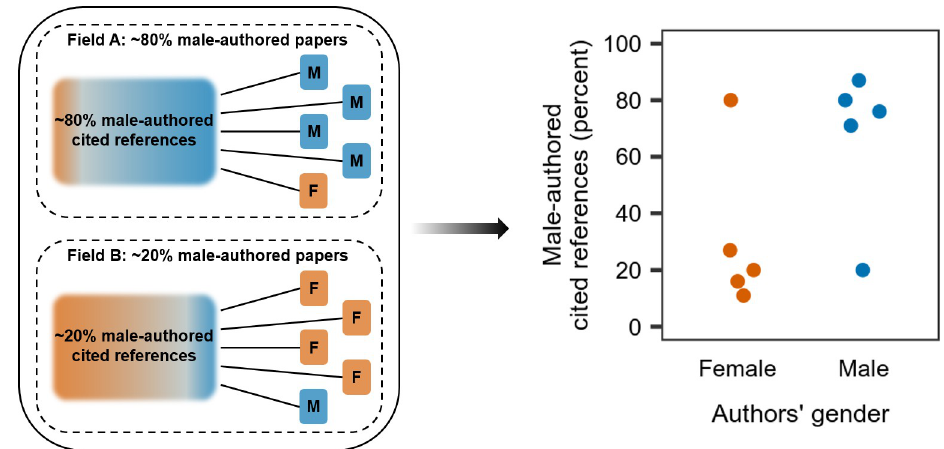
Fig 1. Schematic example illustrating the emergence of gendered citation patterns due to varying gender distributions across topics. On the left, female-authored and male-authored papers (denoted with “F” and “M” respectively) in two different fields and the gender distribution among their cited references are illustrated. Papers from one field are assumed to have one joint risk pool of papers to be cited. The plot on the right shows the resulting shares of male-authored cited references on the aggregated level. Even though this difference is solely based on the varying gender distribution across topics, it may be erroneously interpreted as a gender homophily bias in the authors’ citation